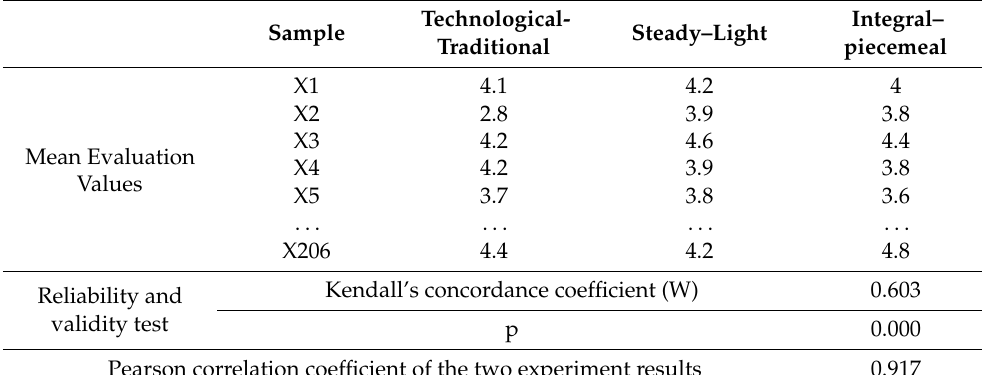
Table 3. The result and analysis of the retest